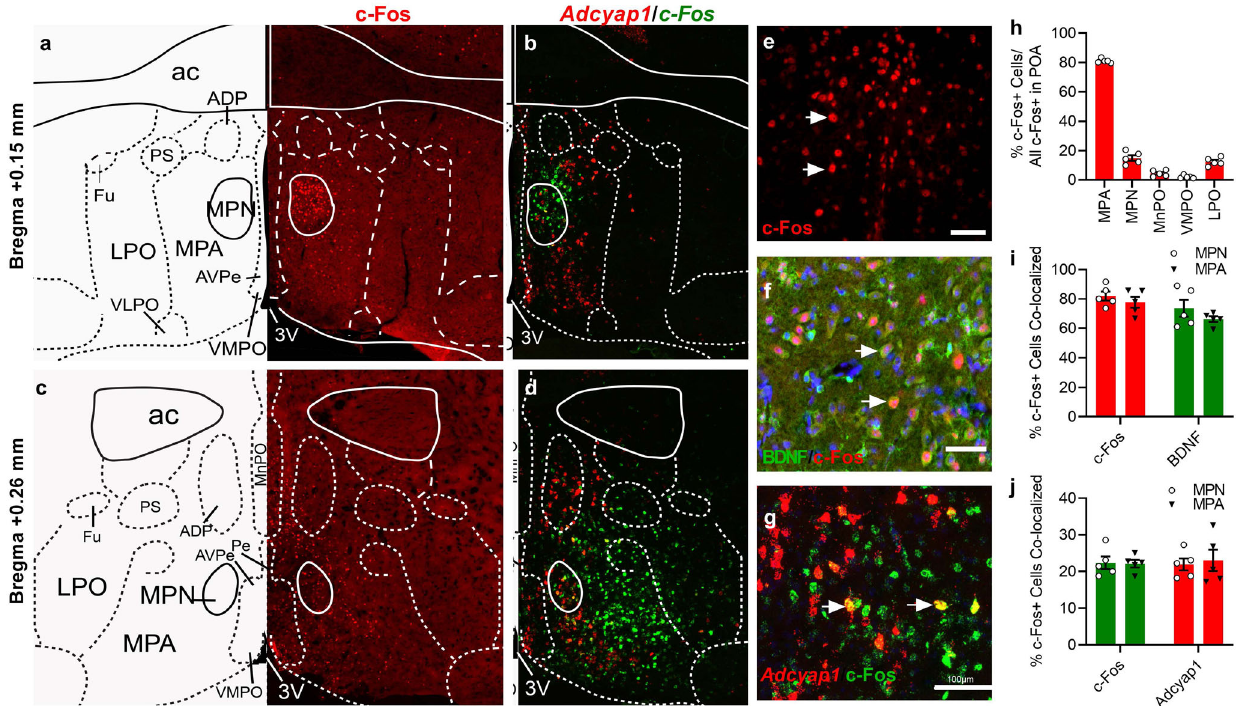
Fig. 5 | DBS-induced expression of WSN markers. a , c Immunohistochemical staining of c-Fosoncoronalbrainsections at thebregmapoint asindicated. b , d In situ RNAScope labelling of Adcyap1 and c-Fos mRNAs. e – g Higher magni fi cation imagesofc-Fosstaining( c ),andtheco-localisationofc-FoswithBDNF( f )and c-Fos with Adcyap1 . h Quanti fi cations of the ratio of c-Fos positive cells in the indicated